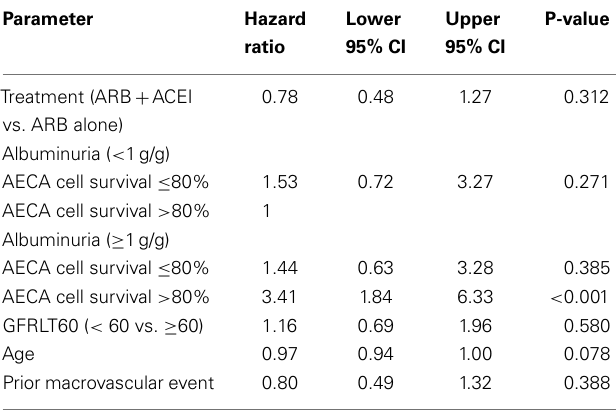
line albuminuria × eGFR, baseline albuminuria × age, baseline albuminuria × treatment, or baseline AECA-mediated cell sur- vival × treatment to time to primary endpoint. Table 2 | Cox regression models of risk factors associated with primary endpoint .